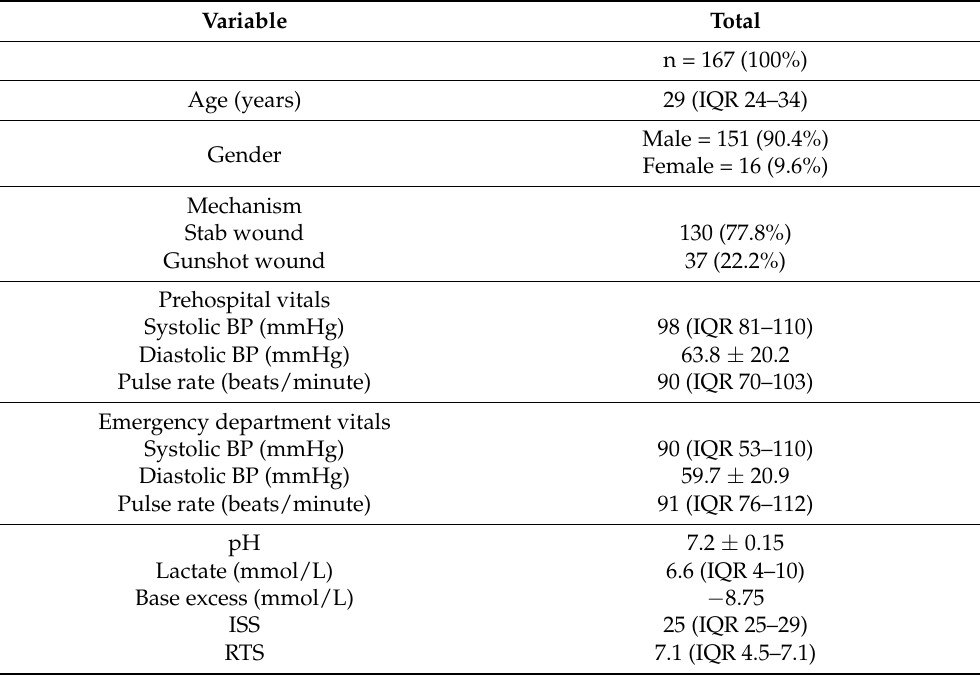
Table 1. Demographics and physiological